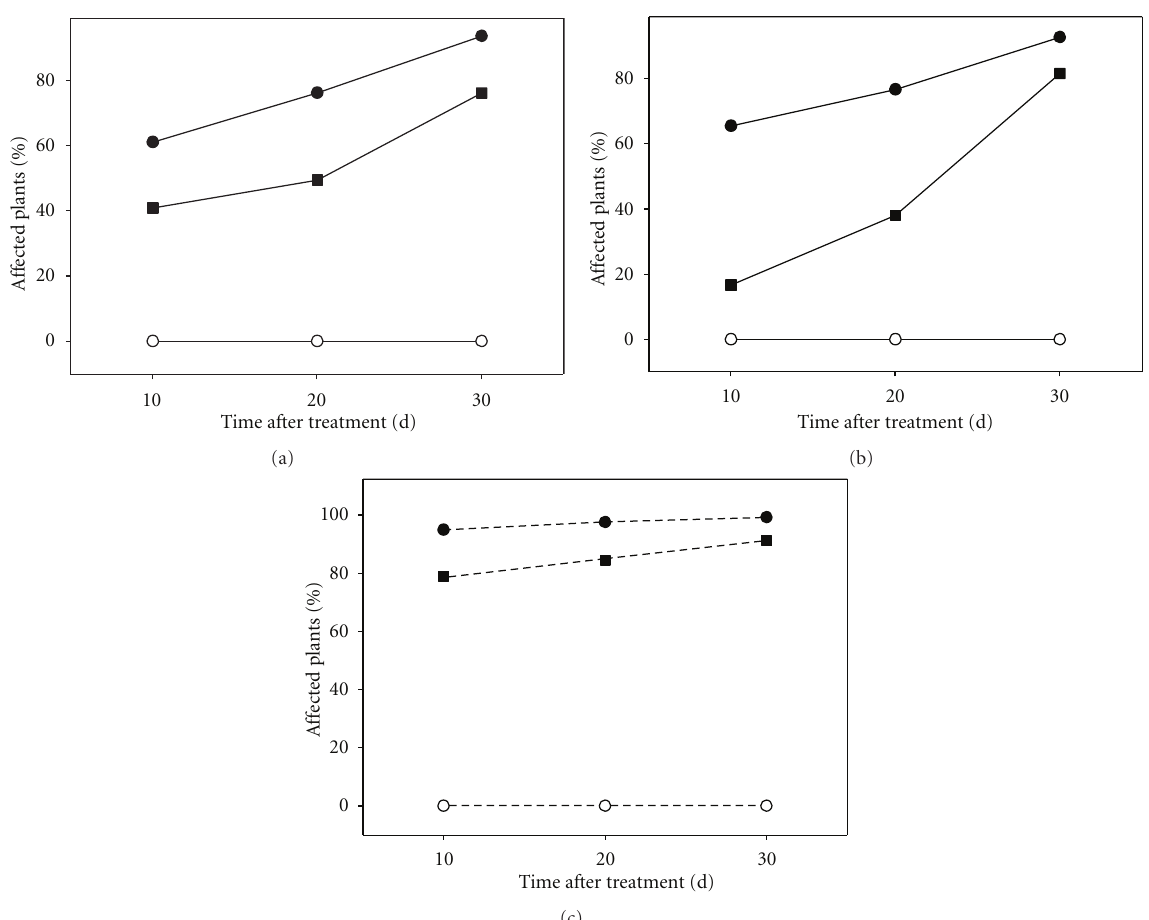
Figure 1: E ff ect of osmotic stress on plant performance in Carrizo citrange cultured in vitro . (a): intact plants a ff ected in the aerial part; (b): intact plants a ff ected in the root tissue; (c): micropropagated shoots a ff ected. Control plants (open circle), plants cultured under moderate (filled square) or severe (filled circle) osmotic stress